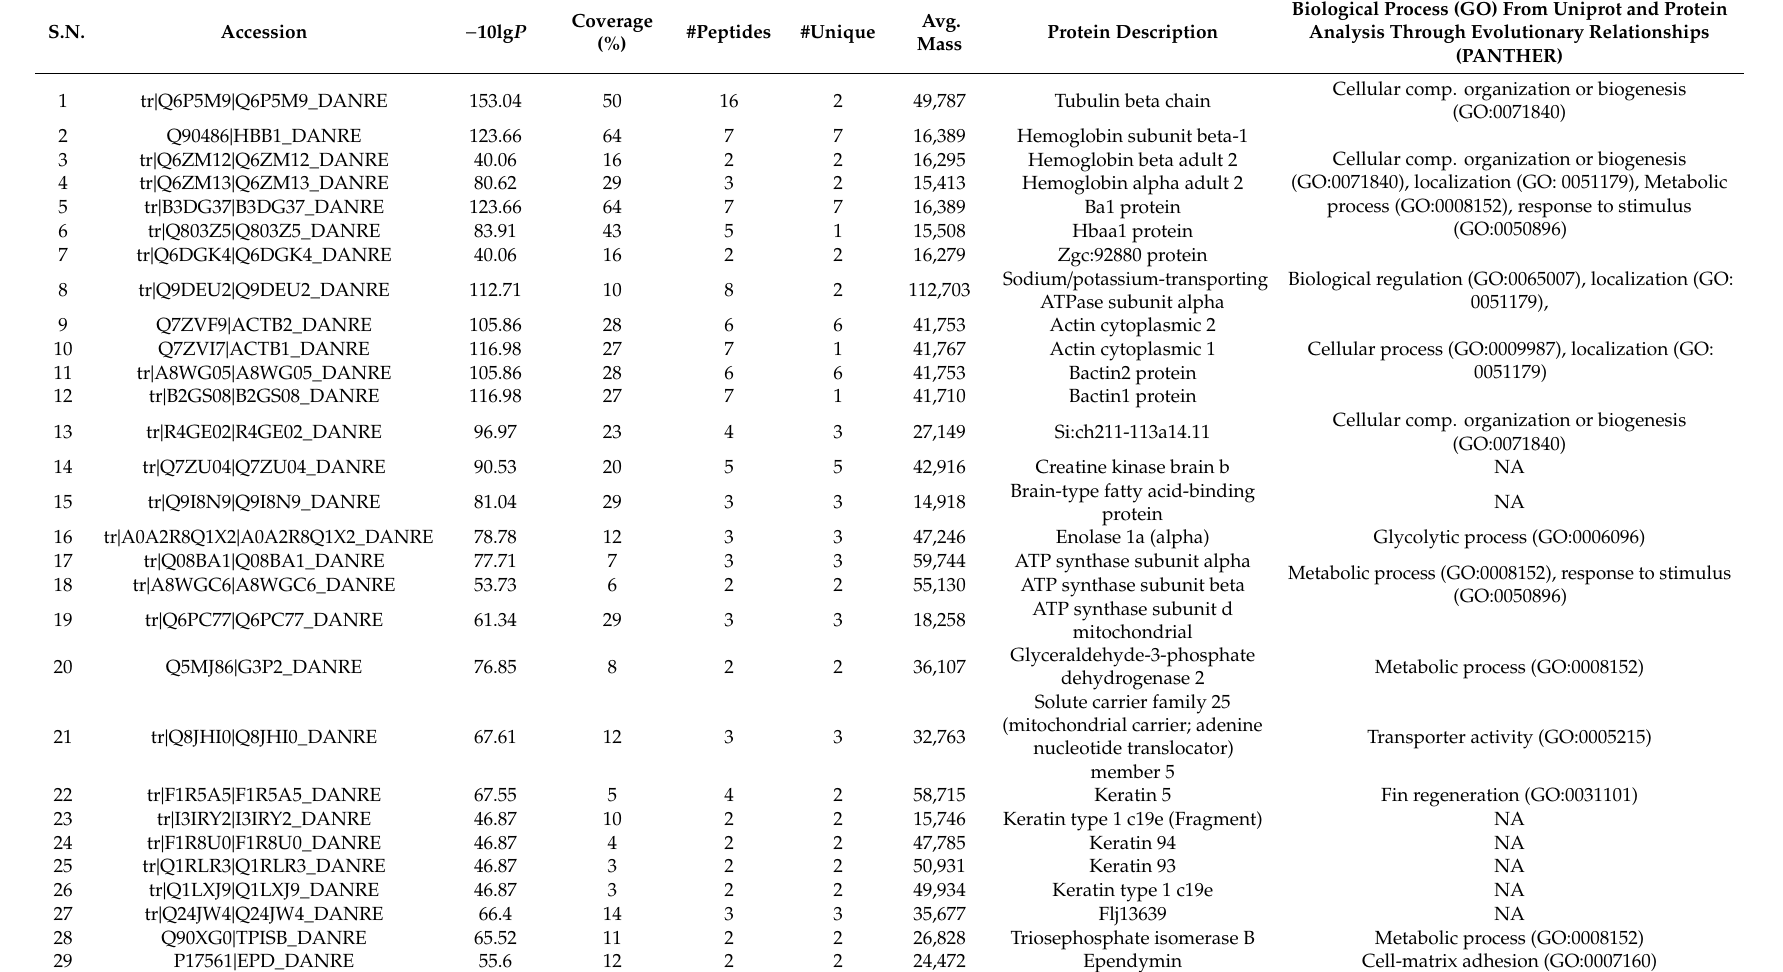
Table 3. List of 77 proteins identified by LCMS / MS analysis from normal zebrafish (control) group brain protein extract.